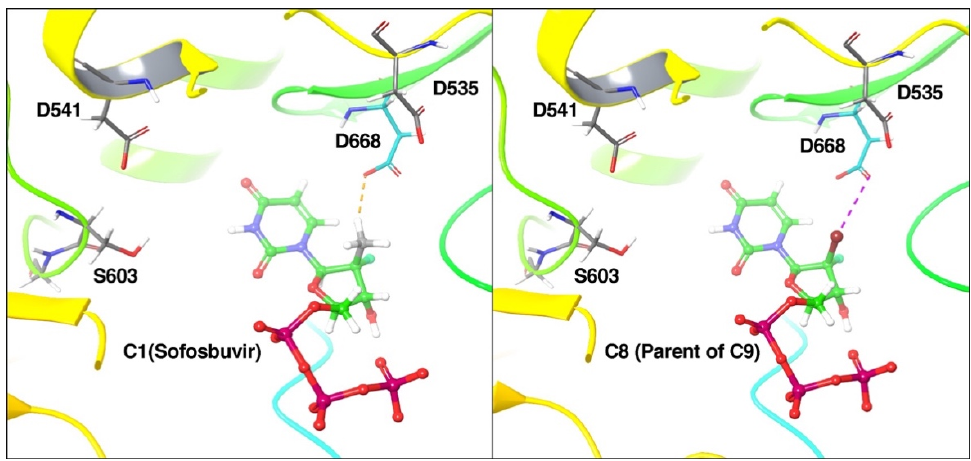
Figure 3. Predicted binding mode of compounds 2 (cid:48) -fluoro,2 (cid:48) -methyluridine-5 (cid:48) -triphosphate, and C8-TP in the active site binding pocket of YFV RdRp. Active site residues are shown in grey sticks while compounds are shown in the ball and stick model. The Orange dashed line represents a steric clash and the violet dashed line represents a halogen